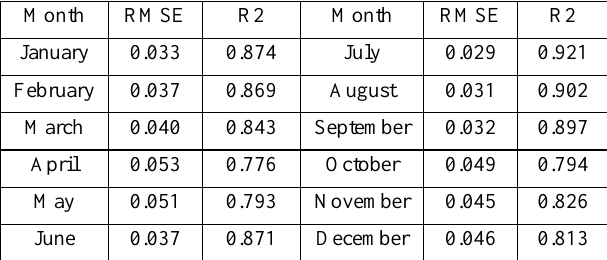
Table 2. The accuracy for 12 months from